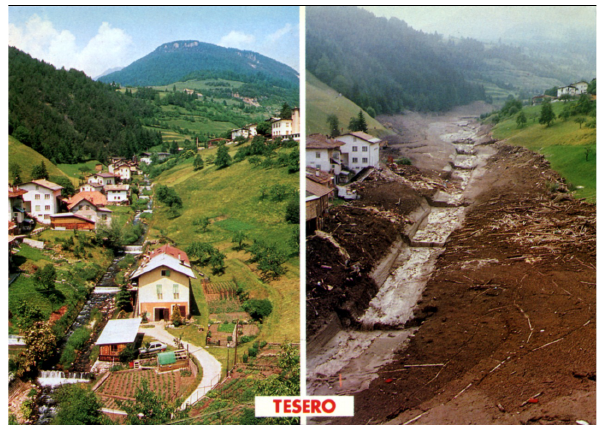
Fig. 13 – Before and after the passage of the mudflow in the Tesero village at section 20 in figure 8 (postcard – Foto Trettel P., ed. Artesan, Tesero).